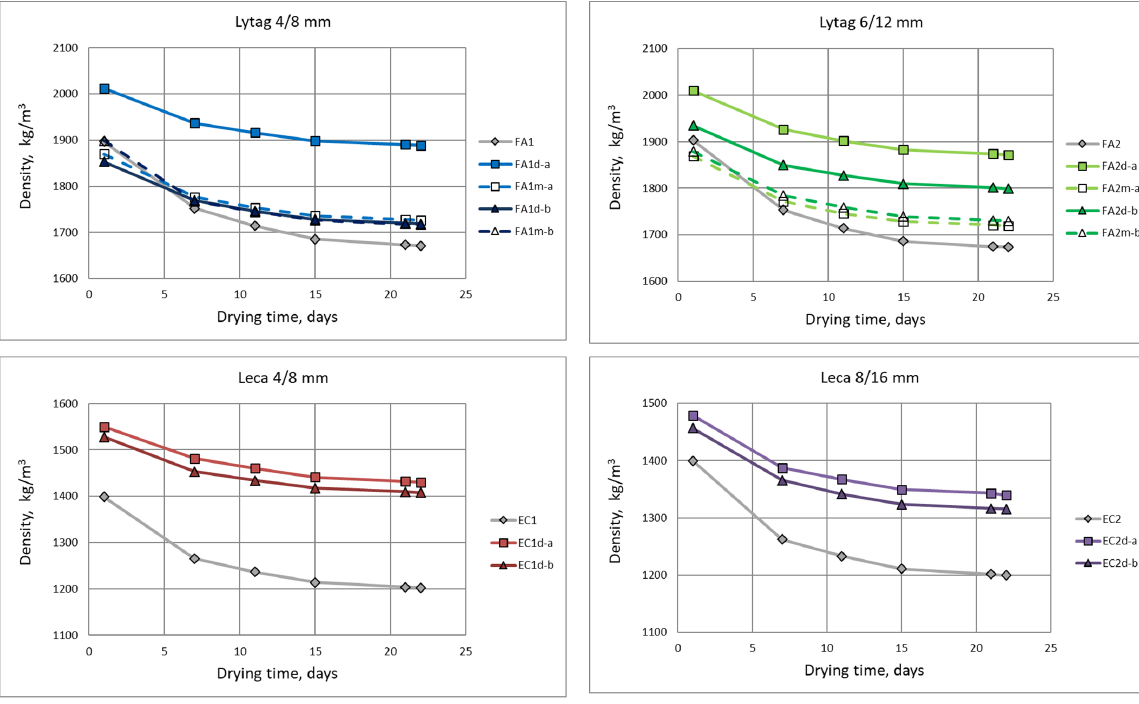
Figure 4. Changes in concrete density over time during drying.